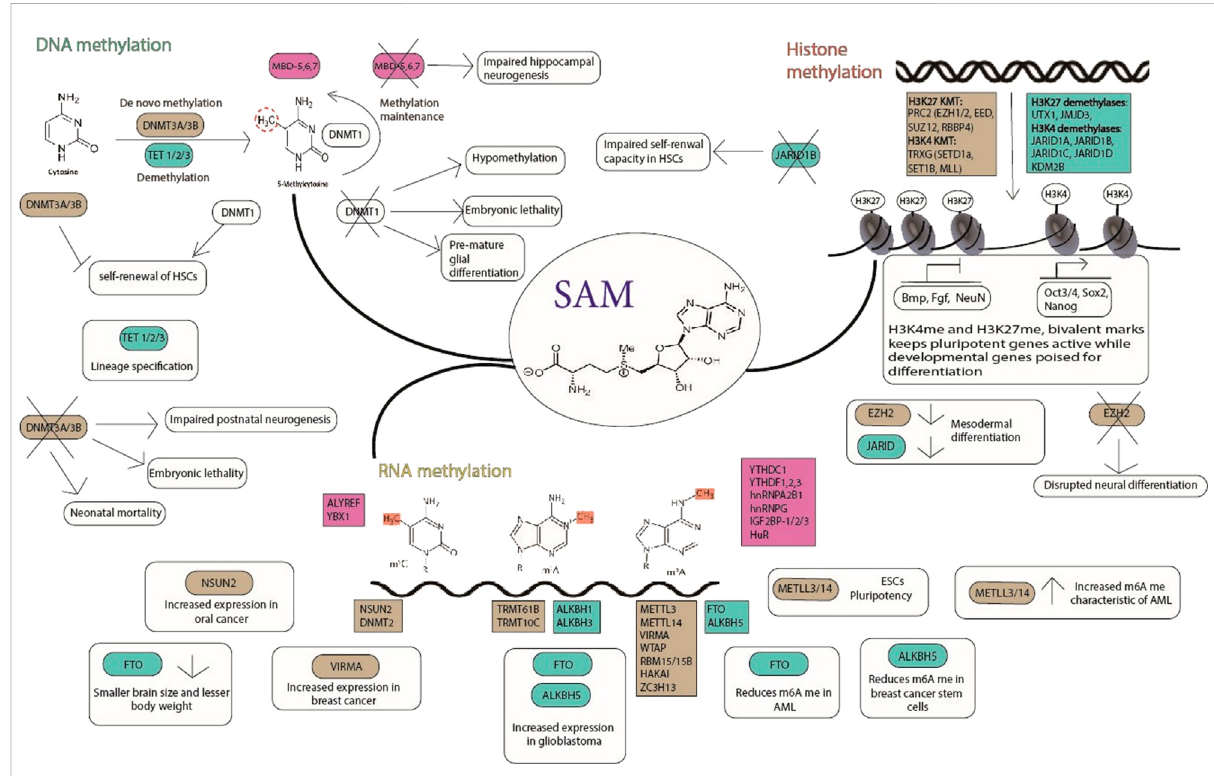
FIGURE 1 Methylation dynamics in stem cells; the readers (pink), writers (brown), and erasers (green) are indicated. SAM (S-adenosyl methionine) is the common methyldonorfor histone, DNAandRNAmethylation. Thewriters,erasersand readersplayimportantroles inmaintainingpluripotency and lineage commitment of stem cells. Their role in physiology and pathophysiology is depicted in the fi